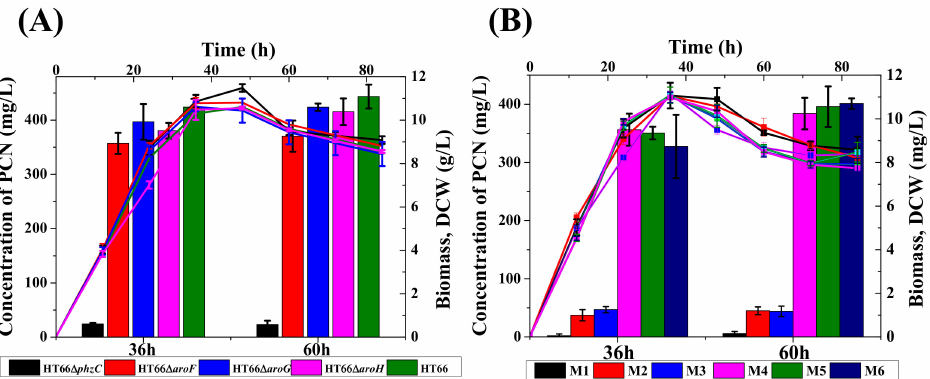
Figure 5. Characteristics growth profile and PCN synthesis of different DAHP synthase-deficient strains. ( A ) Single-deletion, ( B ) Dual deletion. M1: HT66 ∆ phzC ∆ aroF , M2: HT66 ∆ phzC ∆ aroG , M3: HT66 ∆ phzC ∆ aroH , M4: HT66 ∆ aroF ∆ aroG , M5: HT66 ∆ aroF ∆ aroH , M6: HT66 ∆ aroG ∆ aroH . DCW (line), Concentration of PCN